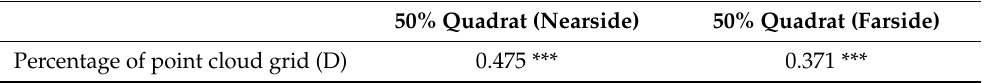
Table 5. Correlation analysis of the percentage of point cloud grid at different locations.